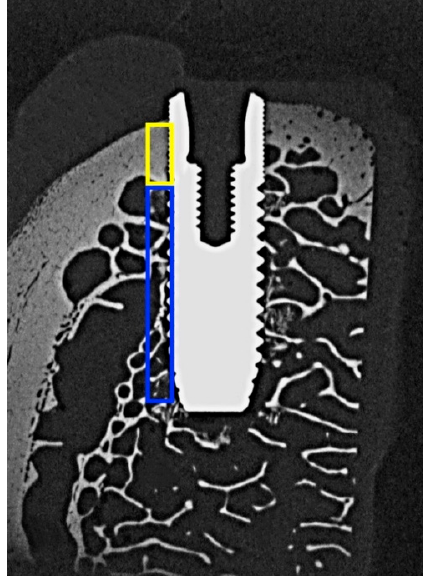
Figure 3. Microradiograph of an OsseoSpeed implant placed in bovine rib bone and sectioned in the bucco-lingual direction. The areas used for determining bone mineral density (BMD) in the cortical and trabecular parts are outlined in yellow and blue color respectively.